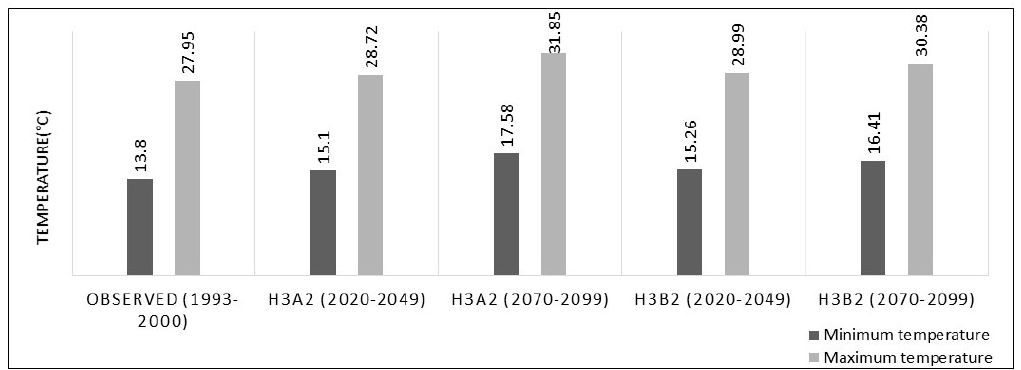
Figure 7. Comparison between the averages annual observed and downscaled temperature under A2 and B2 scenarios.